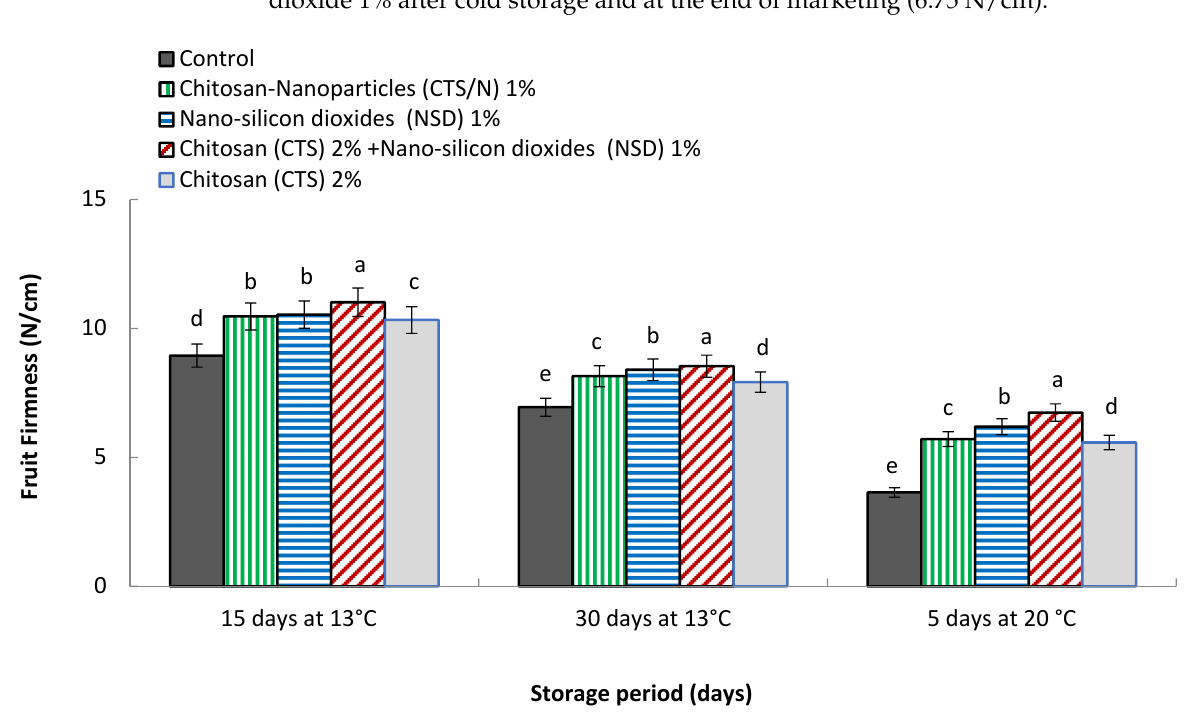
Figure 4. Fruit firmness (N/cm) as a mean of ‘Tommy Atkins’ mangoes from two seasons, stored at 13 ± 1 °C and 90–95% RH for 30 days. Afterward, the fruits were stored at 20 ± 2 °C and 70–75% RH for 5 days as the marketing period. Vertical bars indicate the standard error (SE) of the mean ( n = 5). The superscript letters followed by the same letters are not significantly different according to Duncan’s multiple range test at 0.05 level.